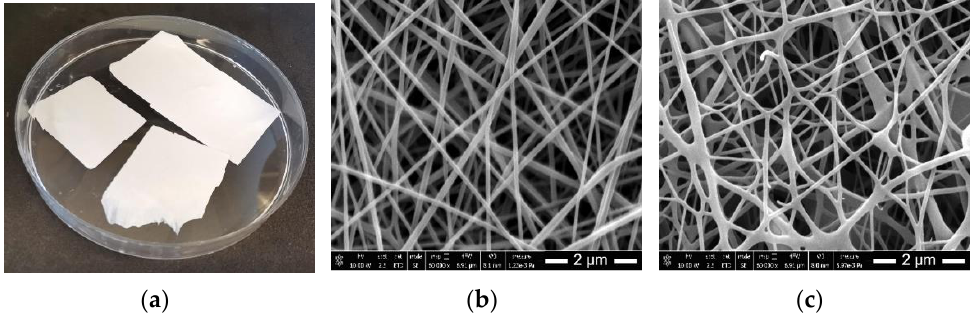
Table 3 . Results from uniaxial tensile tests (σmax = failure stress; εmax = failure strain; E = elastic modulus; U = toughness), water permeability (K Darcy) and SEM analysis (Fiber diameter). Results are expressed as average ± standard deviation ( N = 3 replicates).